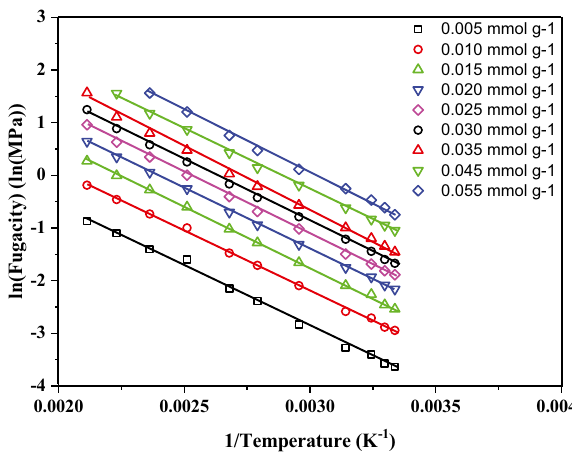
Fig. 3 Clausius–Clapeyron graphs of ln(Fugacity) versus 1/tempera- ture for the supercritical adsorption of methane on Alum 1 shale (data from Ref.